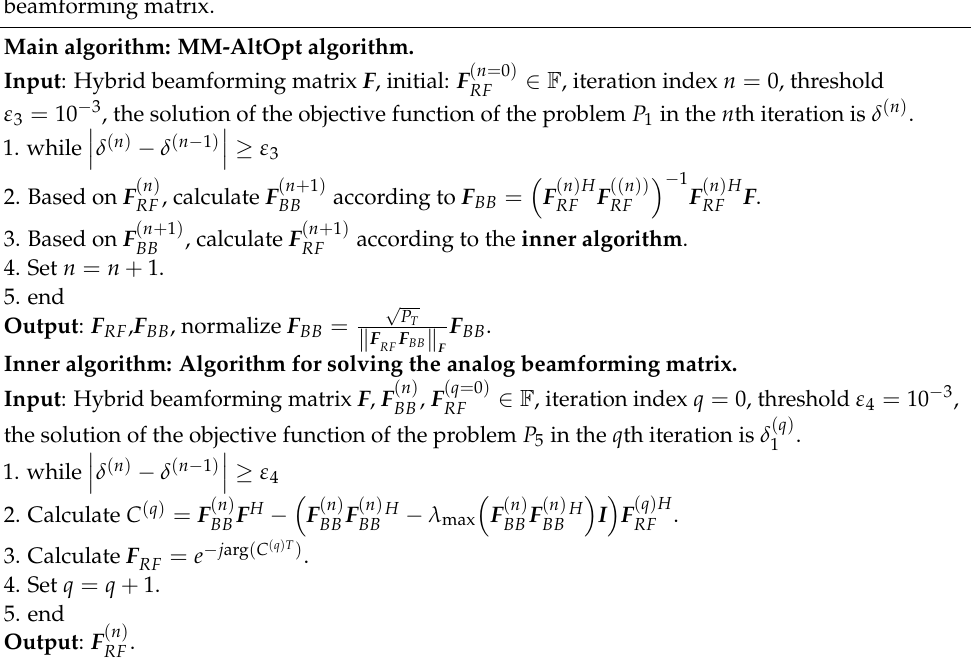
Algorithm 3: Design algorithm of the digital beamforming matrix and the analog beamforming